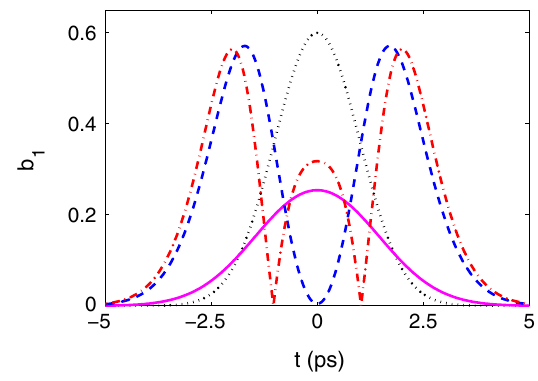
FIG. 3. Time-dependent bunching at the fundamental fre- ¼ 0 : 4 mm ; blue : magenta line for R quency for various R 56 56 ¼ 2 : 9 mm ; red line for R ¼ 3 : 8 mm ; black line for line for R 56 56 the laser profile.